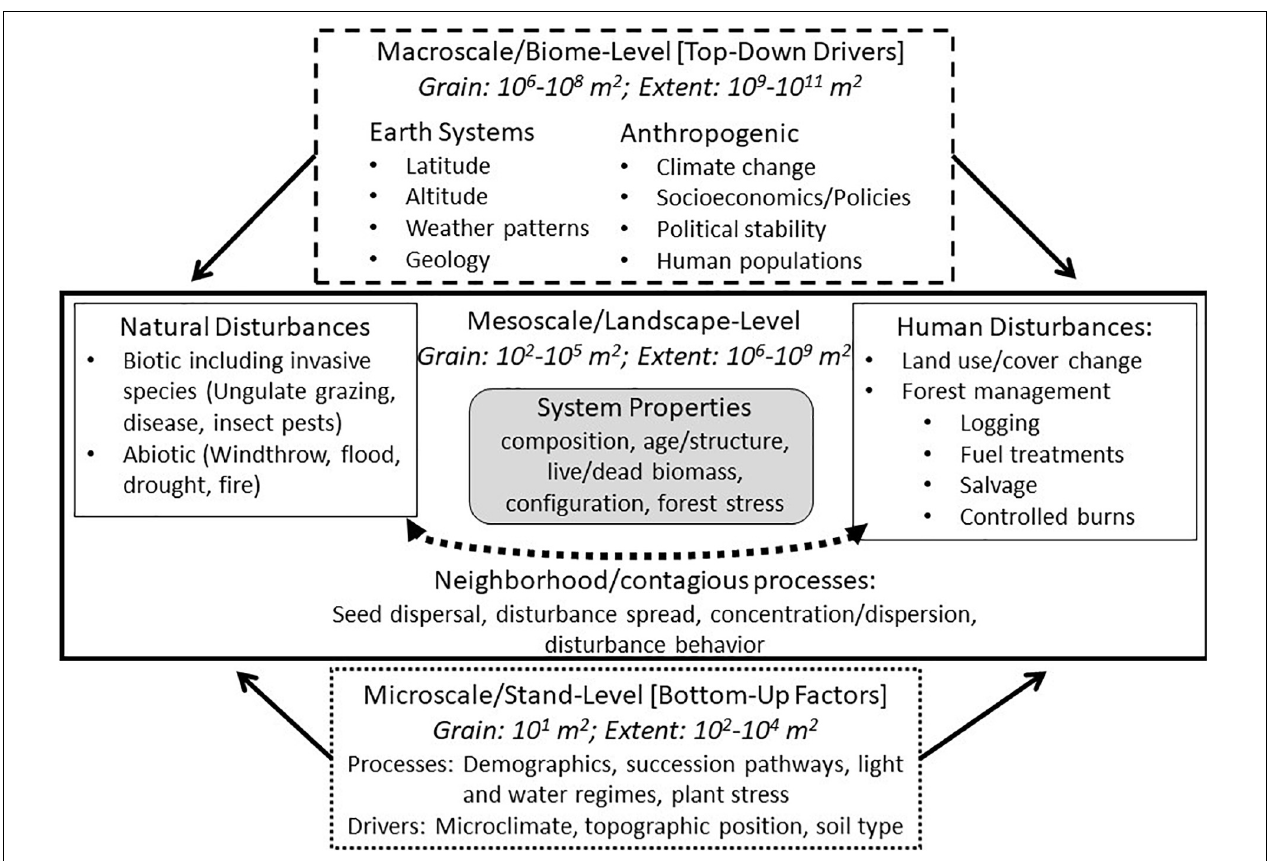
FIGURE 1 | Disturbances at the mesoscale (landscape-level) are affected processes and drivers (bottom-up) at the microscale (stand-level) and higher-order drivers (top-down) at the macroscale (biome-level). Landscape disturbances interact in space and time with reciprocal feedback evident at the landscape level (double-arrow dotted lines). Cross-scale interactions occur where either both bottom-up processes and/or top-down drivers amplify or attenuate disturbance processes within landscapes via threshold behavior in time and space.